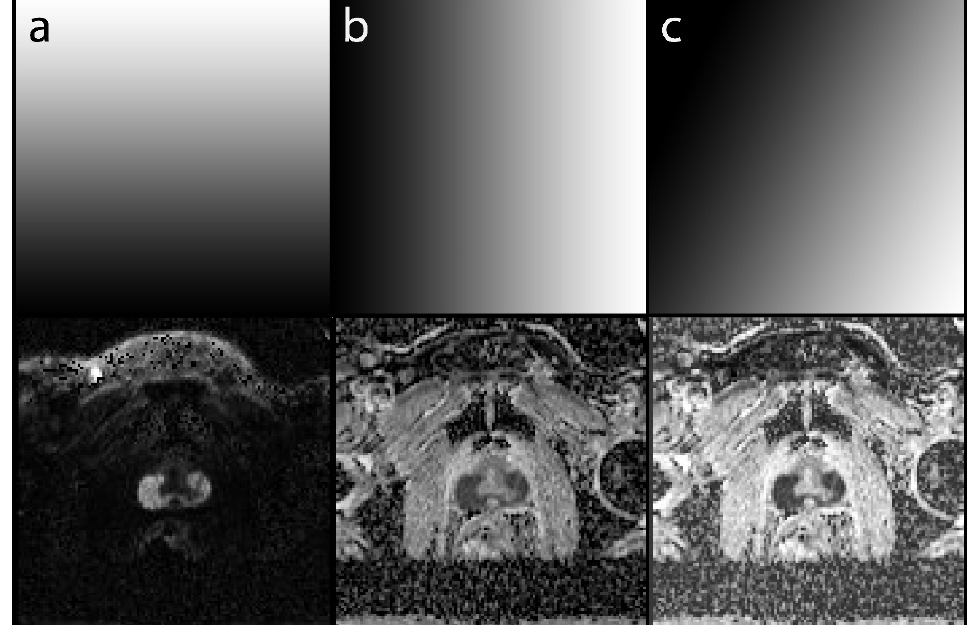
Figure 3. Examples of different readouts from a mcDI dataset created from a high b-value DWI (hbDWI), the ADC, and an intensity map. The selected map is shown in the top row and the resulting mcDI in the bottom row. ( a ) A readout with a strict vertical gradient yields the original DWI. The resulting image contains no ADC information; ( b ) In contrast to ( a ), a strict horizontal gradient yields the original ADC image; ( c ) A tilted gradient yields the mcDI containing both the DWI and ADC information with an even lower signal in the large tumor in the peripheral zone of the prostate and a lighter background.